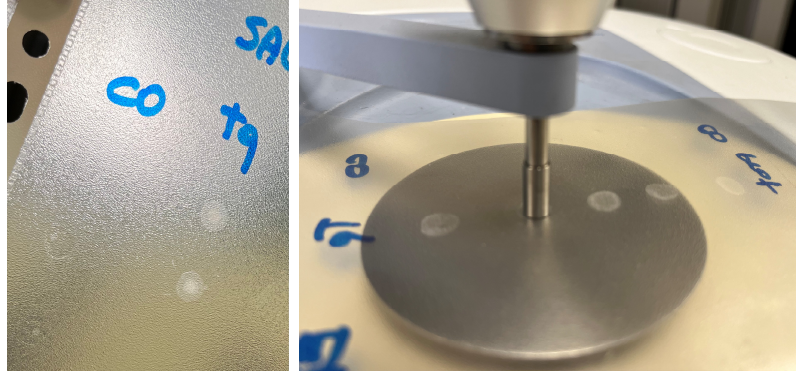
Figure 1. Saliva sample dried spot (SDS) from 50 µL deposition onto PP sheet and “printing” on ATR-FTIR crystal.